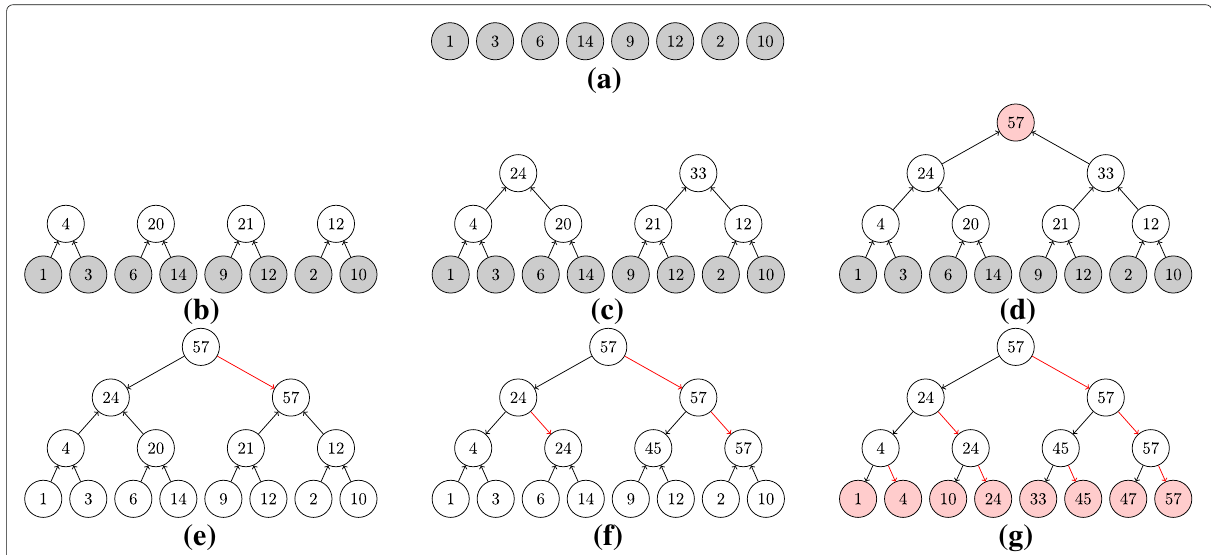
Fig. 2 Example of cumulative sum for N = 8 numbers. Subfigures a – d describe the sum computation, while the remaining balanced binary trees shown in subfigures e – g describe how the backward pass culminates in calculation of the cumulative sum of the given